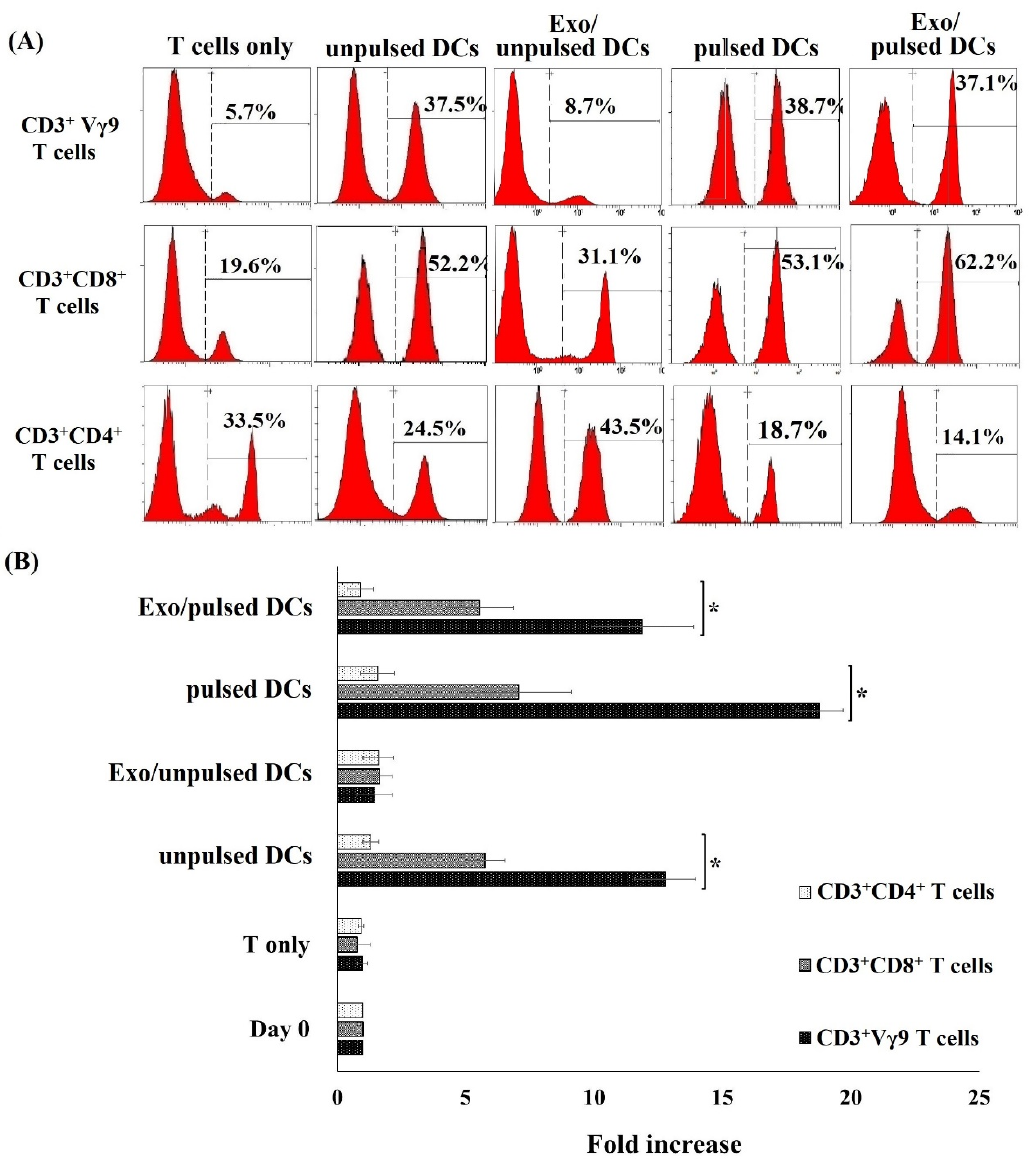
Figure 3. DCs and their exosomes induced the proliferation of allogeneic T cell subpopulation. ( A ) After incubation with pulsed DCs, unpulsed DCs, and Exo / pulsed DCs, the percentage of both CD3 + V γ 9 T cells and CD3 + CD8 + T cells increased compared to T cells without such treatments. ( B ) Fold increase in the number of CD3 + V γ 9 T cell and CD3 + CD8 + T cell induced by DCs and their exosomes. Both pulsed DCs and their exosomes successfully induced CD3 + V γ 9 T cell and CD3 + CD8 + T cell proliferation, meanwhile the number of CD3 + CD4 + T cells did not increase. Exo / pulsed DCs could induce the percentage of these cell sub populations similar to unpulsed DCs did, but exosomes isolated from unpulsed DCs did not. Data was presented as mean ± SD in quadruplicate cultures (* p < 0.05). DCs: dendritic cells; pulsed DCs: A549 tumor cell lysate-pulsed DCs; unpulsed DCs: A549 tumor cell lysate-unpulsed DCs; Exo / unpulsed DCs: exosomes isolated from unpulsed DCs; Exo / pulsed DCs: exosomes isolated from pulsed DCs.